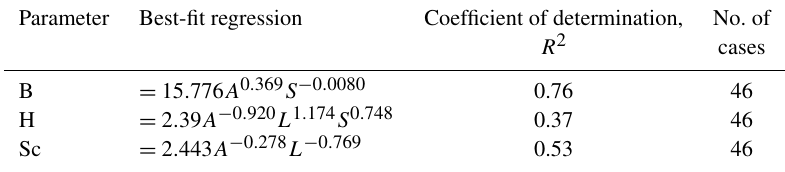
Table 3. Regression analysis for parameter estimation using basin area, stream length and slope in the Han River basin. Parameter Best-fit regression Coefficient of determination, No. of R 2 cases